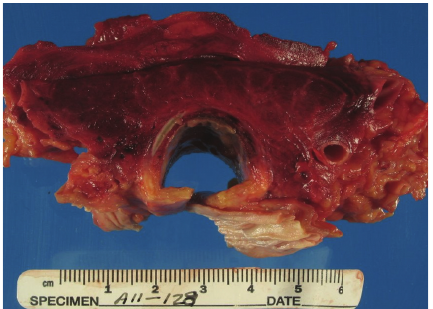
Figure 1: Autopsy gross digital image of cross section of trachea (bottom) surrounded by hemorrhagic thyroid gland and soft tissue. The thyroid and strap muscles are intensely hemorrhagic due to infarction from the vascular involvement by fibrin thrombi infected with the Aspergillus hyphae.